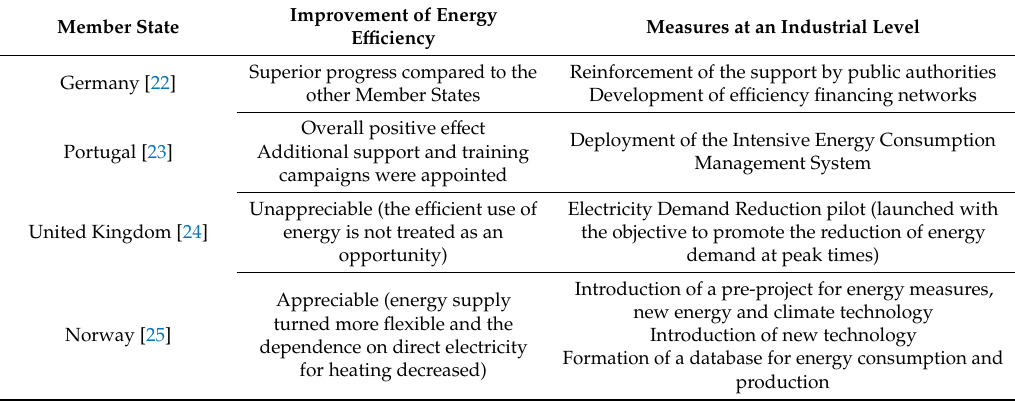
Table 1. Summary of energy e ffi ciency strategic and technological framework at European Union (EU) member